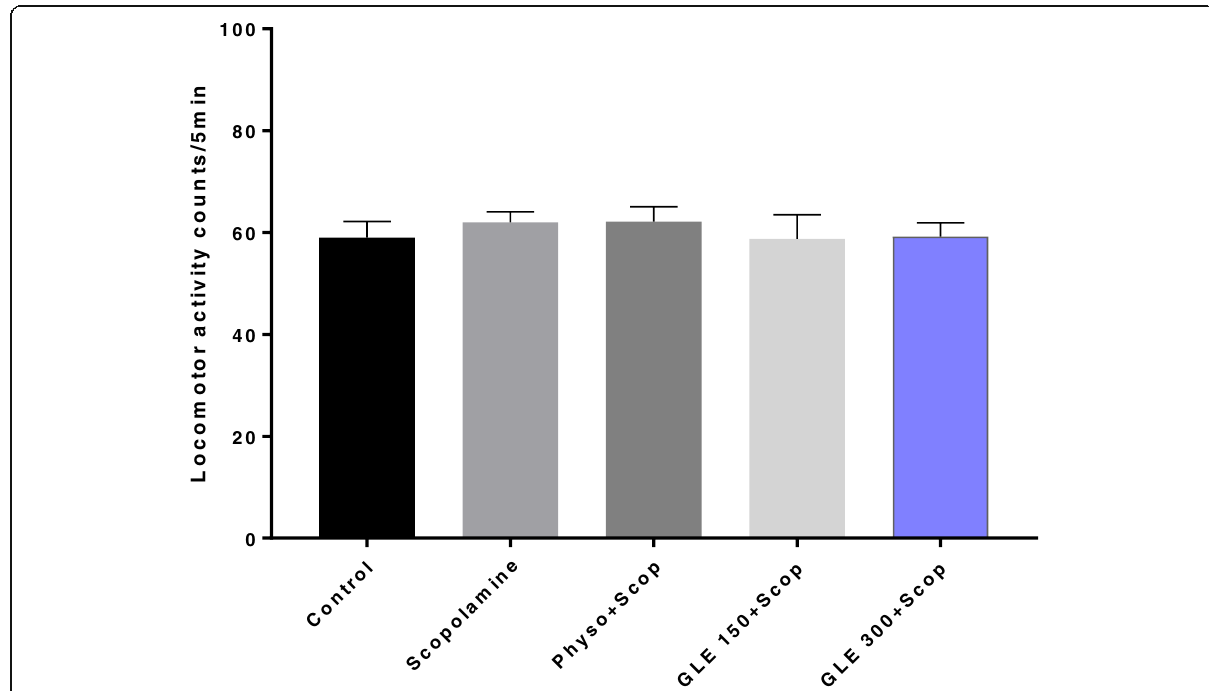
Fig. 4 Effect of Ganoderma lucidum on locomotor activity of mice. Animals per group (n) = 6; The values are mean ± SEM (One-way ANOVA followed by Tukey ’ s Post hoc test). ap < 0.05, bp < 0.01, cp < 0.001 when compared with scopolamine alone treated group. * p < 0.05, ** p < 0.01, *** p < 0.0001 when compared with DW treated (control) group DW, distilled water; GLE 150, Ganoderma lucidum extract (150 mg/kg); GLE 300, Ganoderma lucidum extract 300/kg; Scop, Scopolamine; Physo,